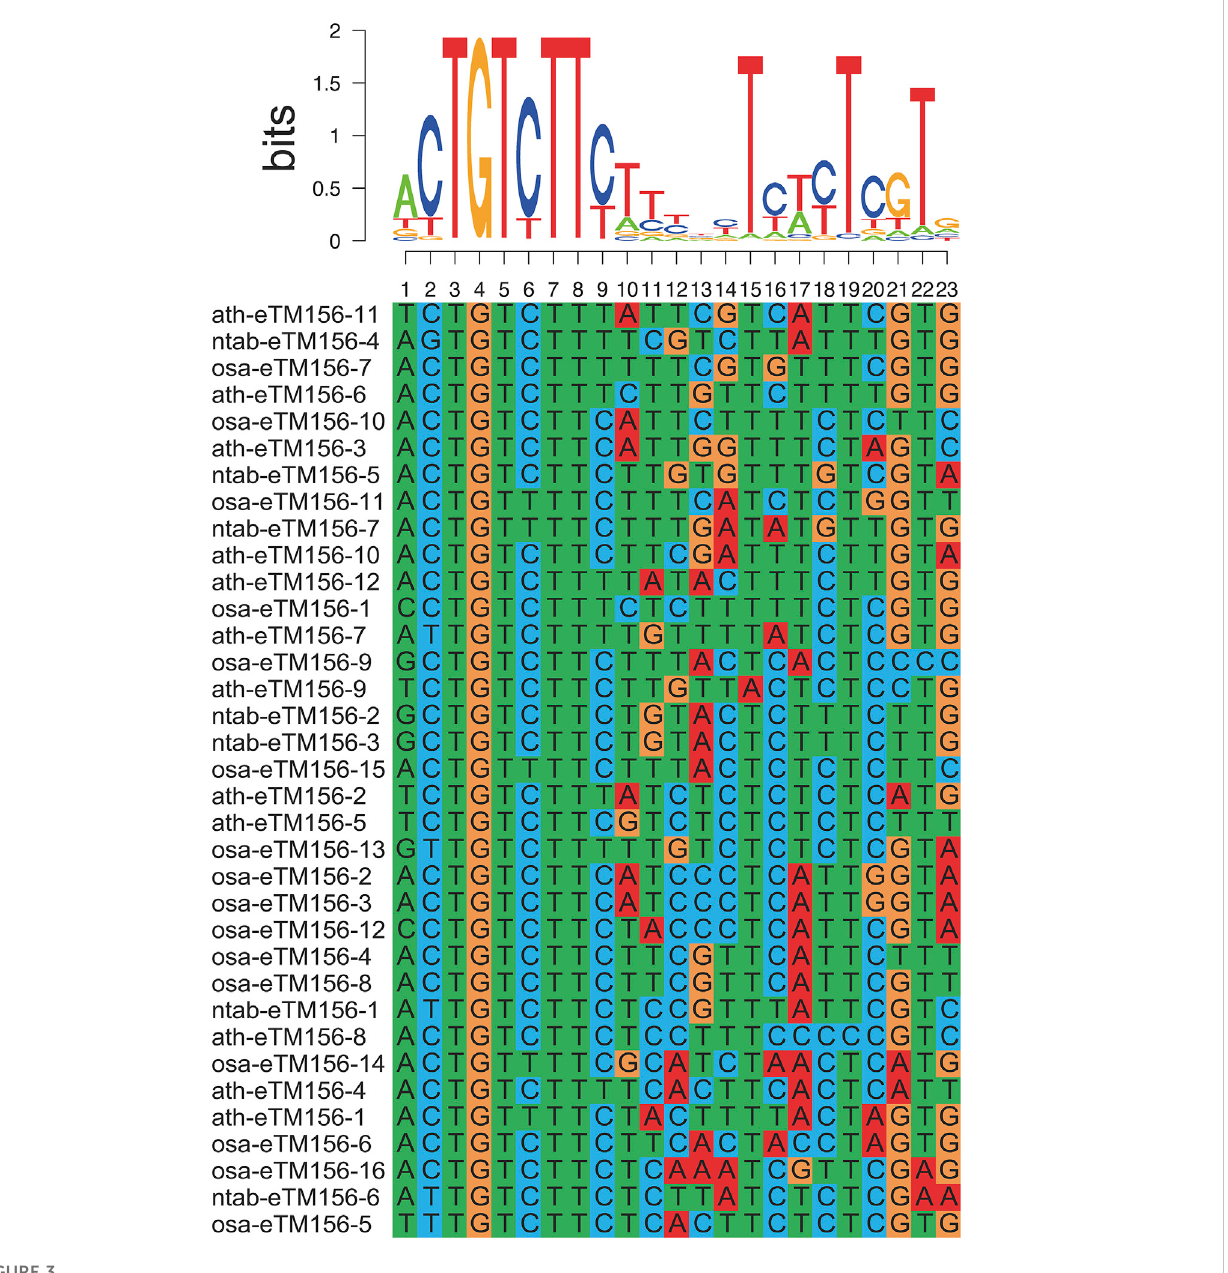
FIGURE 3 Alignment of lncRNAs as eTMs of miRNA156 in tobacco, rice, and Arabidopsis.